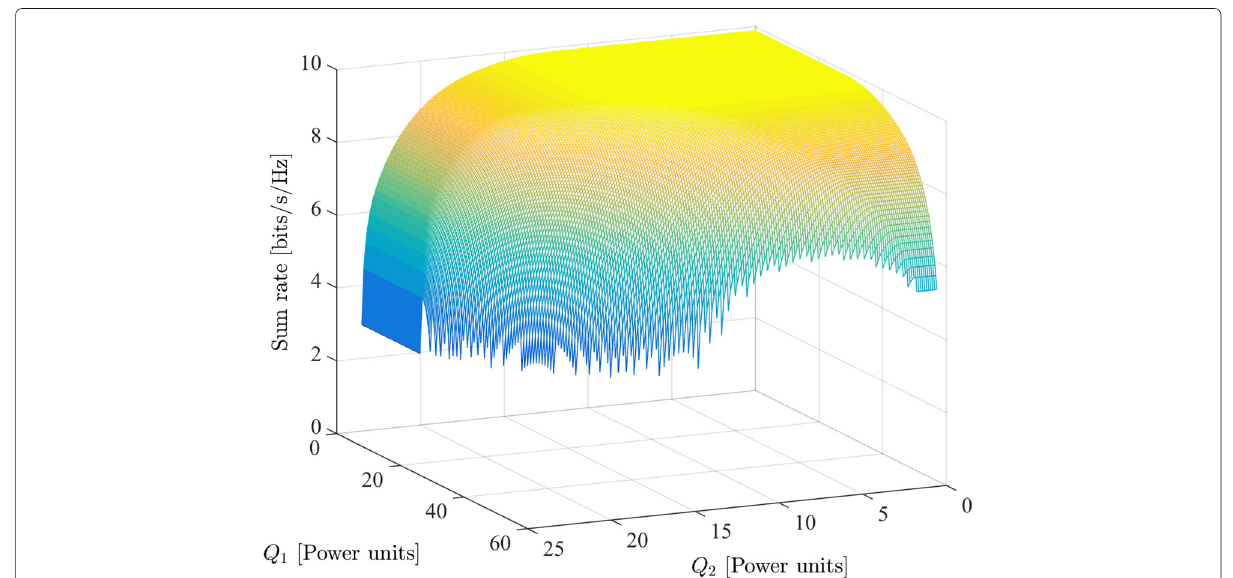
Fig. 2 Three-dimensional R-P region. Representation of the three-dimensional R-P region of problem (13). The figure represents the existing trade-off between the optimal solution of the problem, i.e., the weighted sum rate, and the two power harvesting constraints